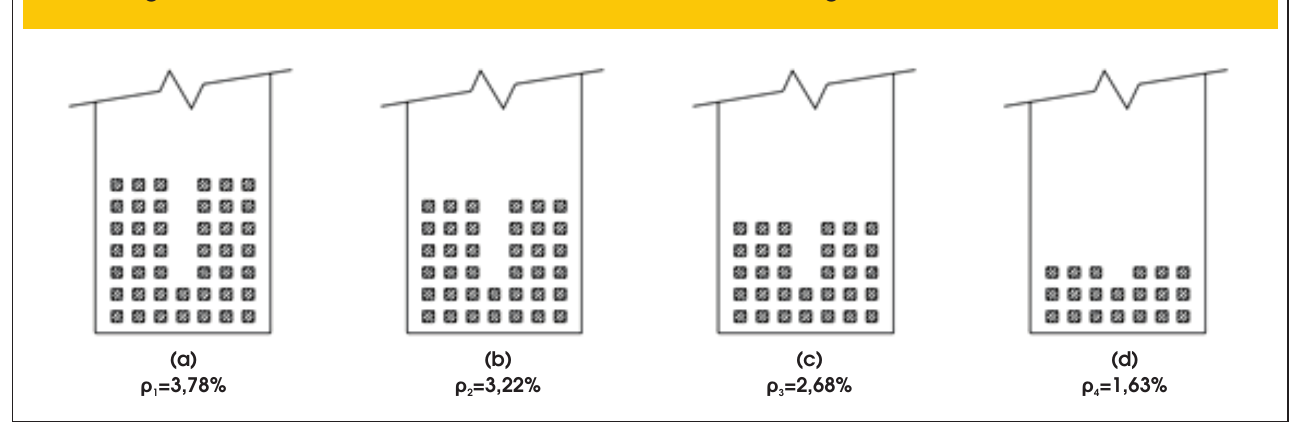
Figure 9 – Distribution of bars in the cross section of the longitudinal beam (MENDES [1] )